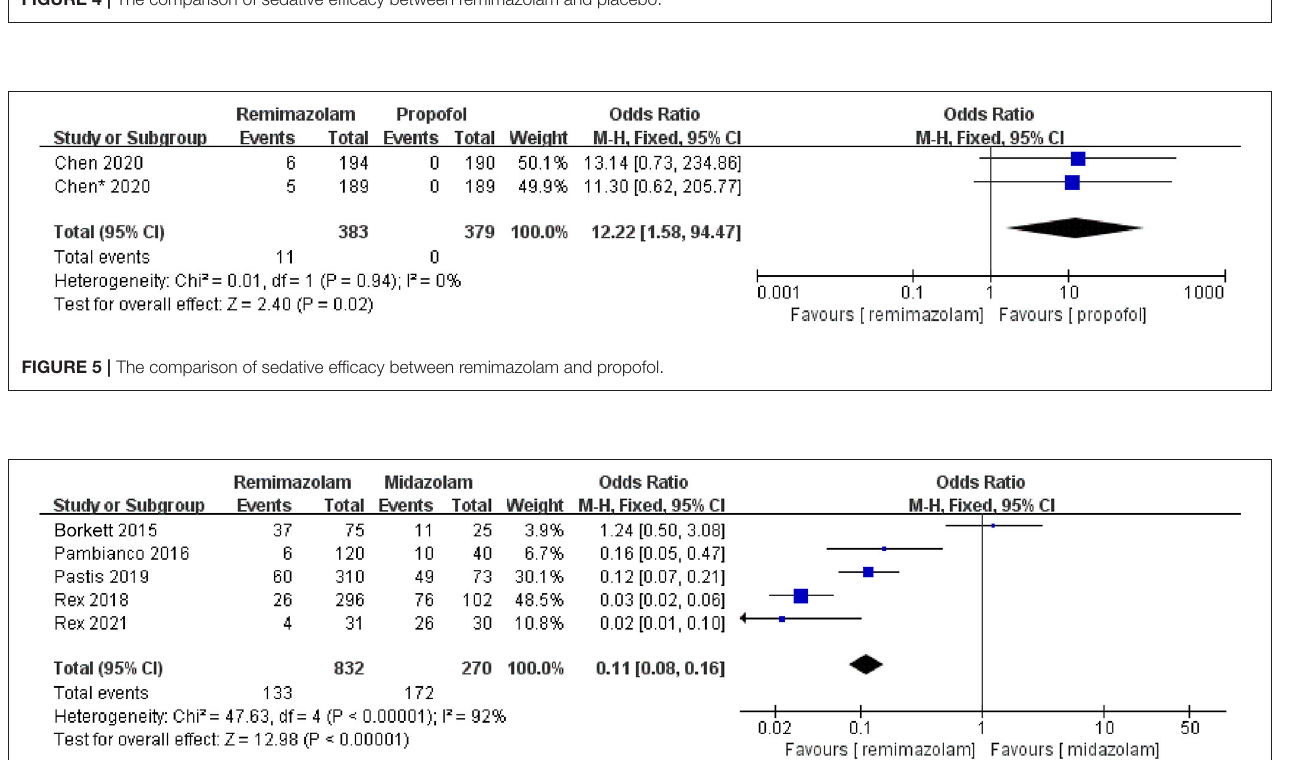
FIGURE 4 | The comparison of sedative efficacy between remimazolam and placebo.